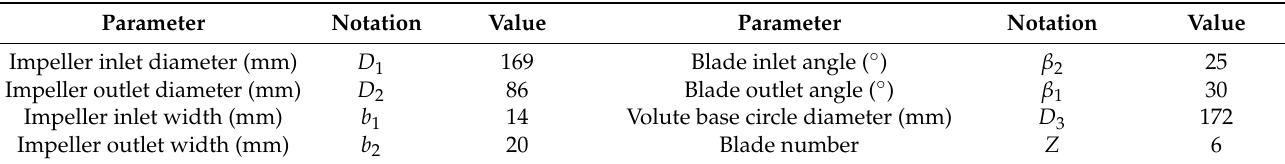
Figure 1. Calculation model of the PATs. Table 1. Main geometric parameters of the